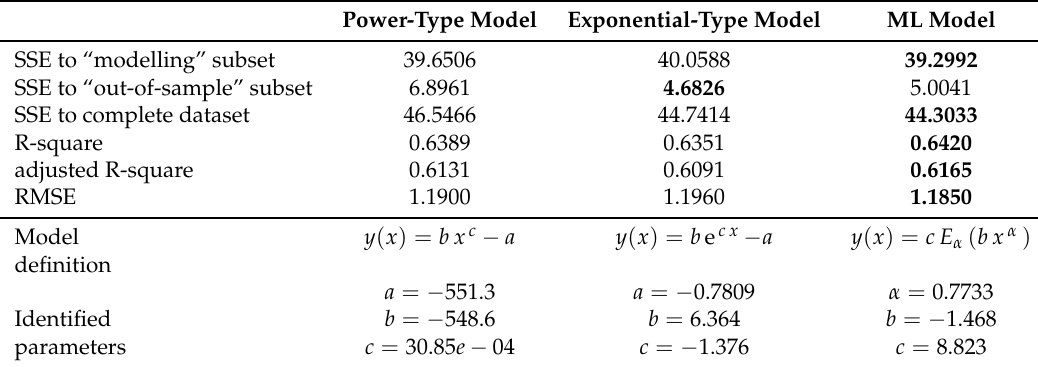
Table 3. The statistical results of the Swiss Phillips curve